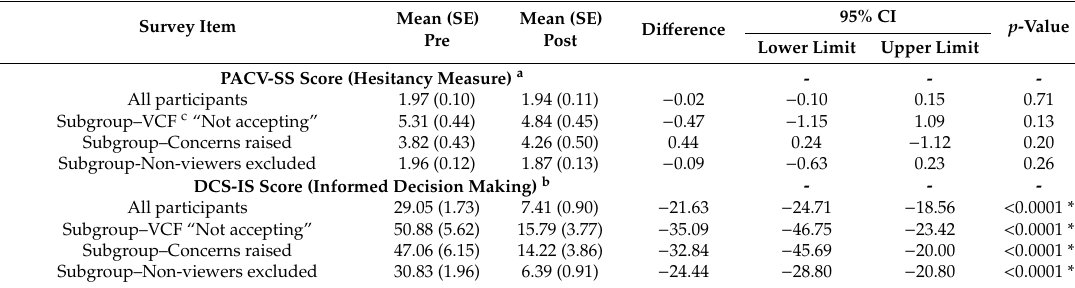
Table 3. Comparison of Hesitancy and Informed Decision Making Pre and Post Intervention.